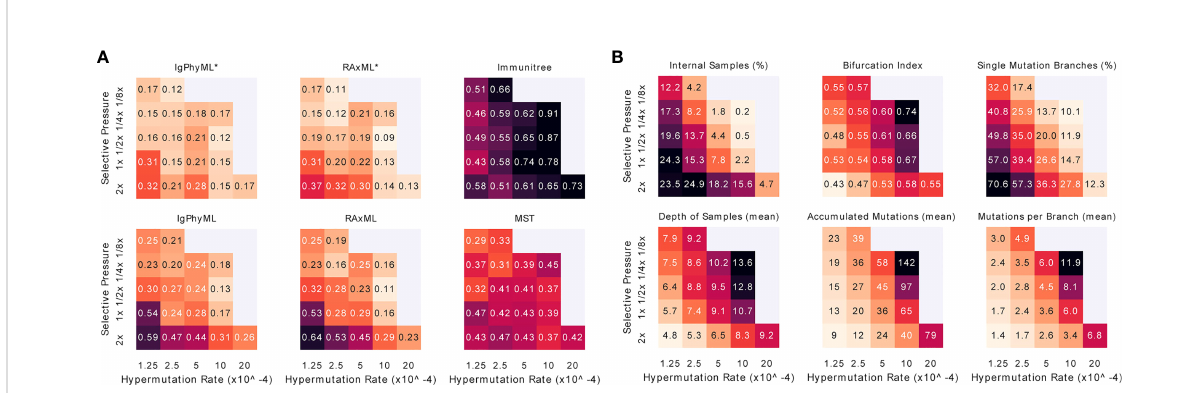
FIGURE 8 For varying levels of selective pressure (A) , rate of hypermutation ( µ ), and all reconstruction methods except BRILIA, we show (A) tree error measured by the triplet edit distance TED and (B) properties of the true tree. When the mutation rate is too high and the selective pressure is too low, the simulation never ends, meaning that the total af fi nity needed to overcome the antigen is never reached; these conditions are missing from the fi gure. For other evaluation criteria see Figure S7. *: contracted